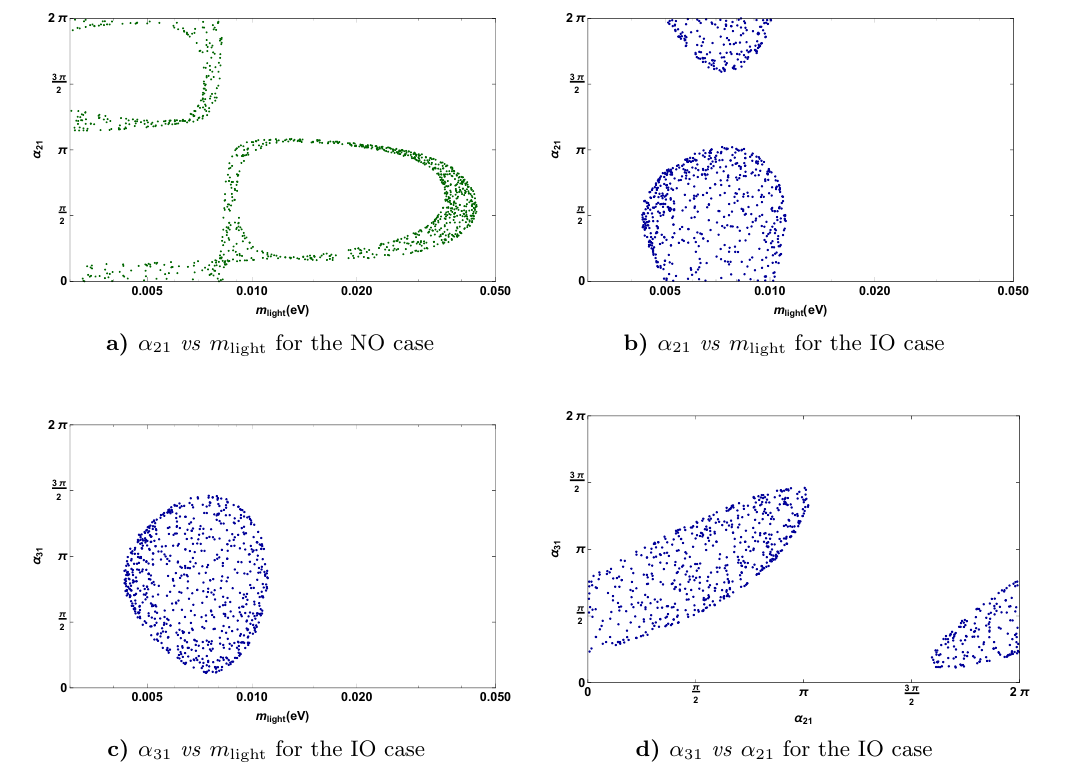
Figure 5 . Correlation plots for the Majorana CP phases and the lightest active neutrino mass for the only points that satisfy (cid:17) B within its experimental determination at 3 (cid:27)